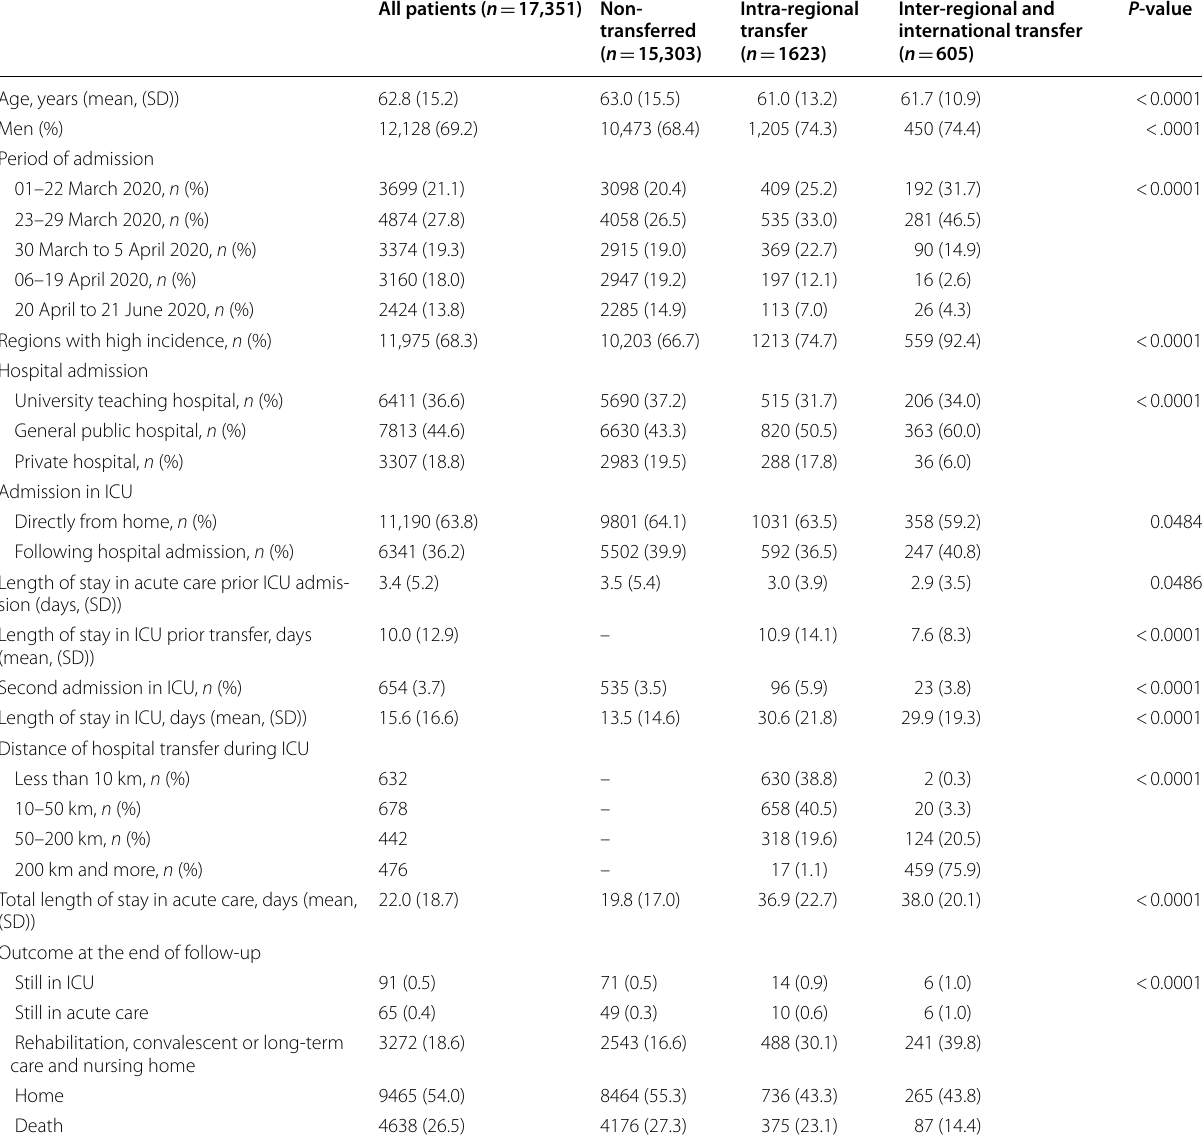
Table 1 Characteristics of the study population according to transfer status for patients with COVID‑19 hospitalized at an